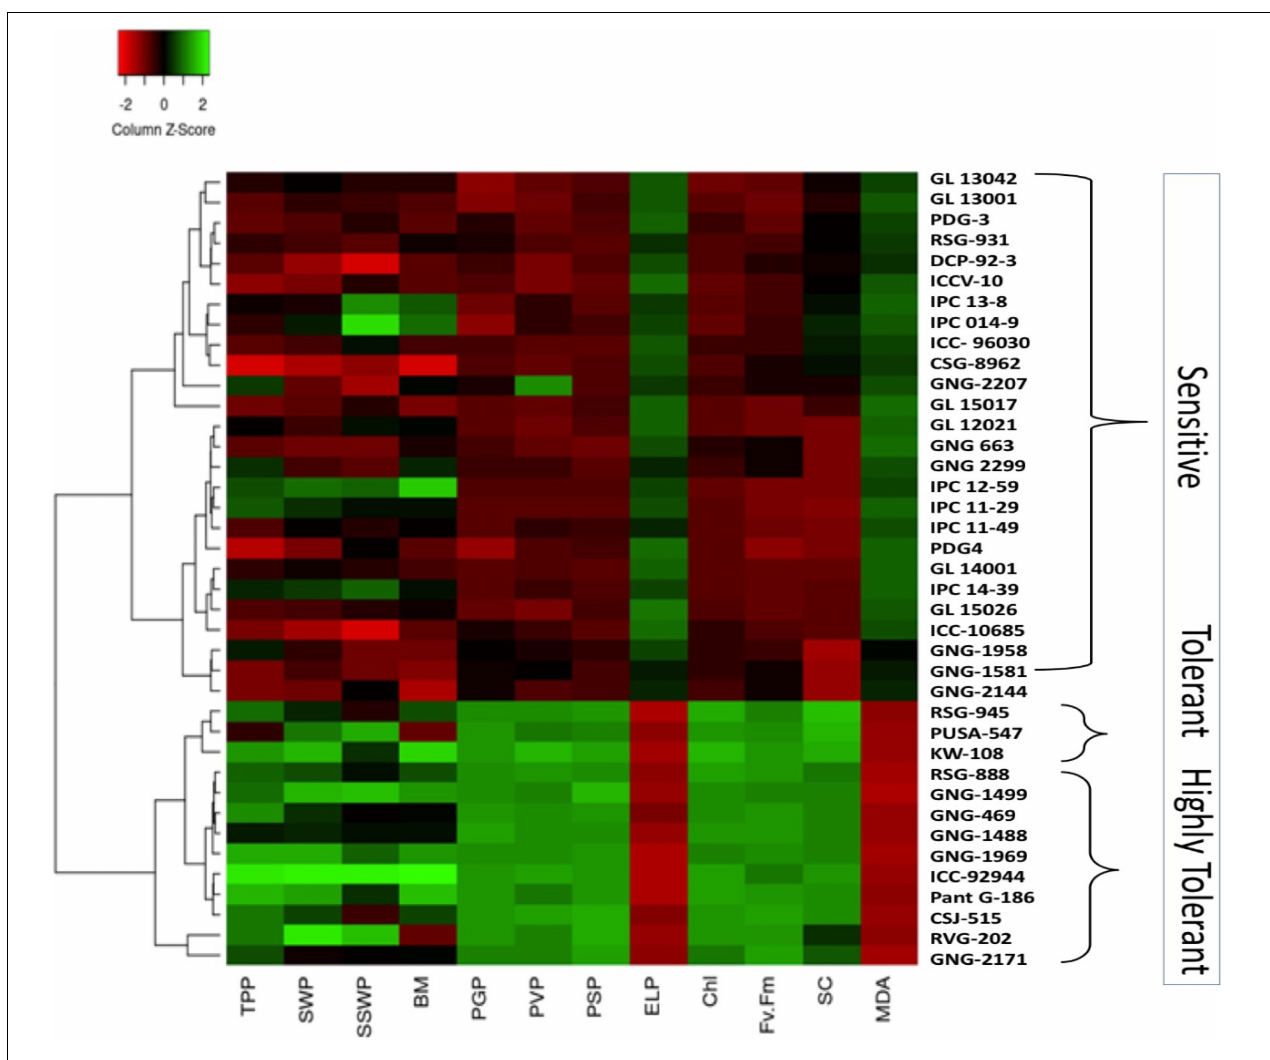
FIGURE 8 | Heat map based on the response of chickpea genotypes to heat stress in